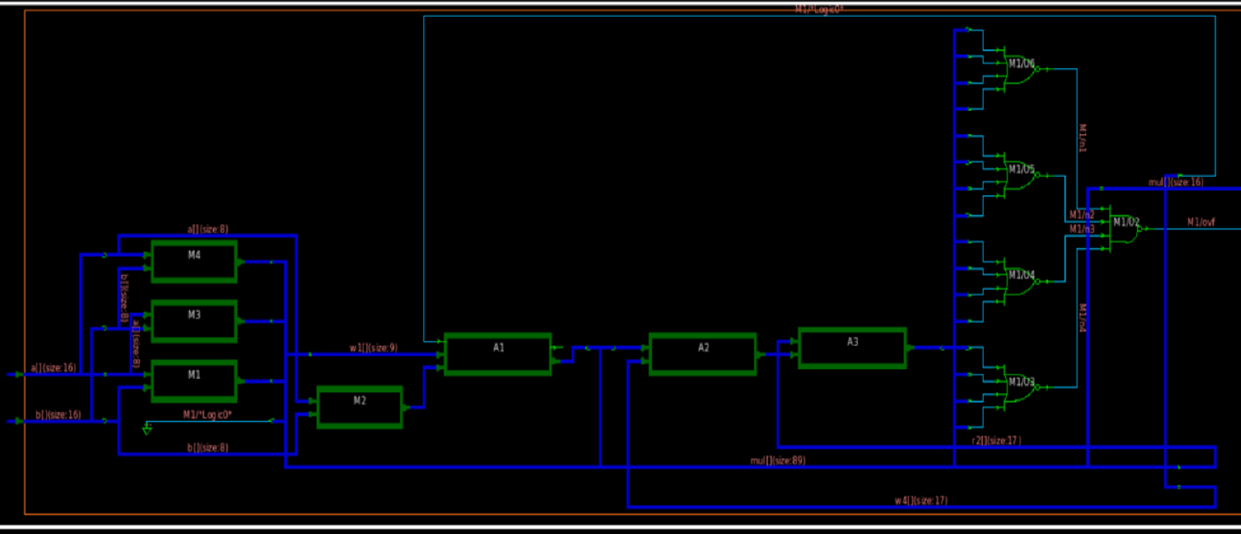
Figure 9. Circuit for the 16 × 16 Vedic multiplier generated through